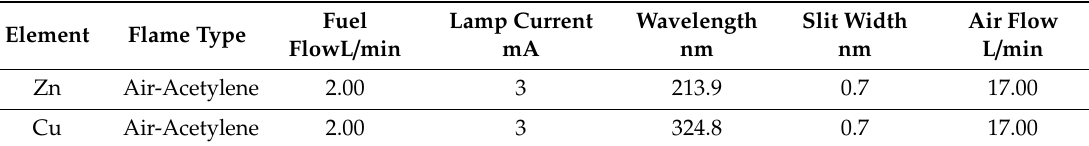
Table 3. Instrumental analytical values of investigated trace elements in FAAS.